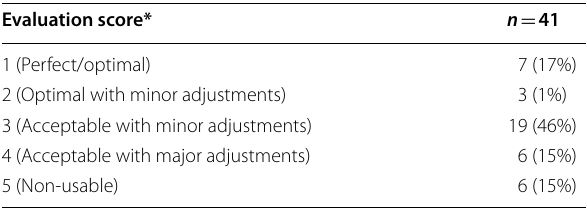
0.017) = Table 4 Evaluation of number of false-positive/false-negative segmentations by AI without manual